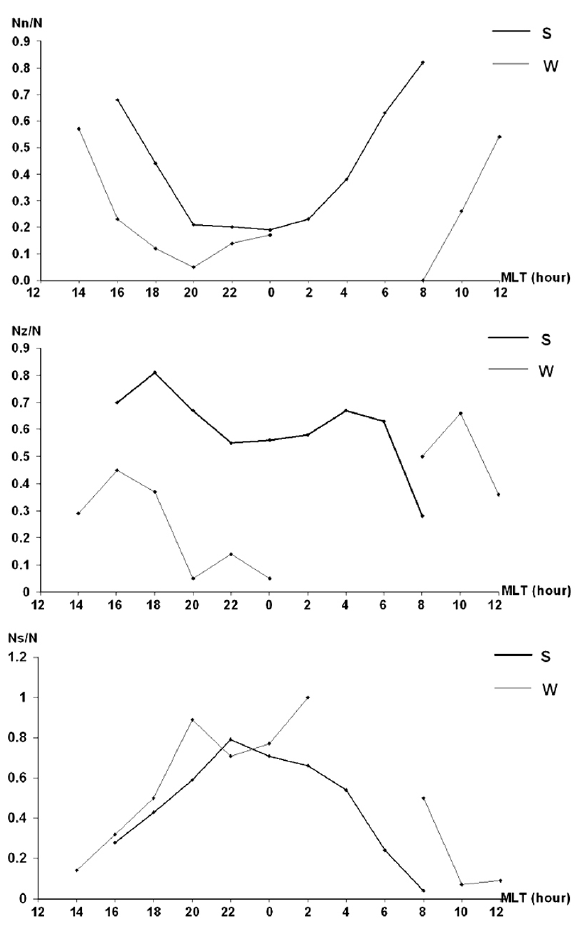
Fig. 12. Type B red aurora. Photo P.